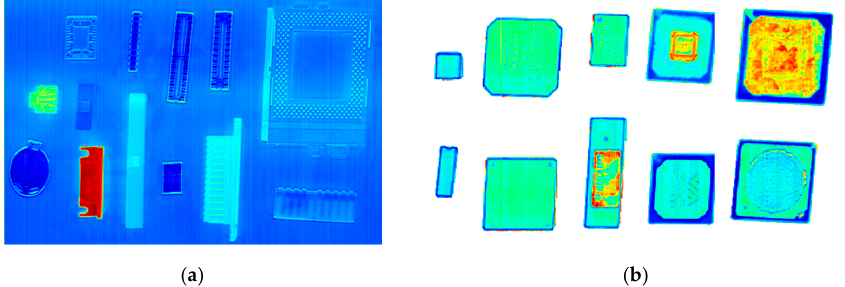
Figure 2. Scanned image of analyzed objects. ( a ) Hyperspectral image of the plastic components from a PC Motherboard; ( b ) Hyperspectral image of Integrated circuits found on a PC Mother- board